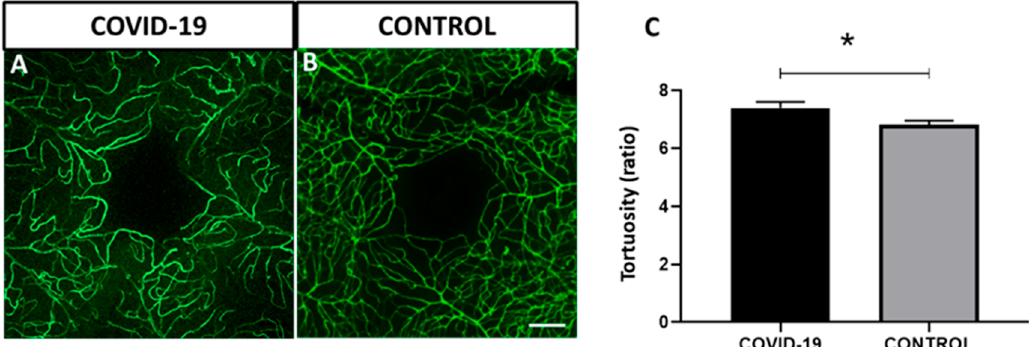
Figure 2. Vessel tortuosity in flat-mounted retinas in COVID-19 and control labelled with lectin (green). ( A – C ) Quantitative analysis in the macular area. Tortuosity is significantly increased in COVID-19 samples compared to controls. Error bars indicate S.E.M. * p < 0.05. Scale bar: 100 µm.